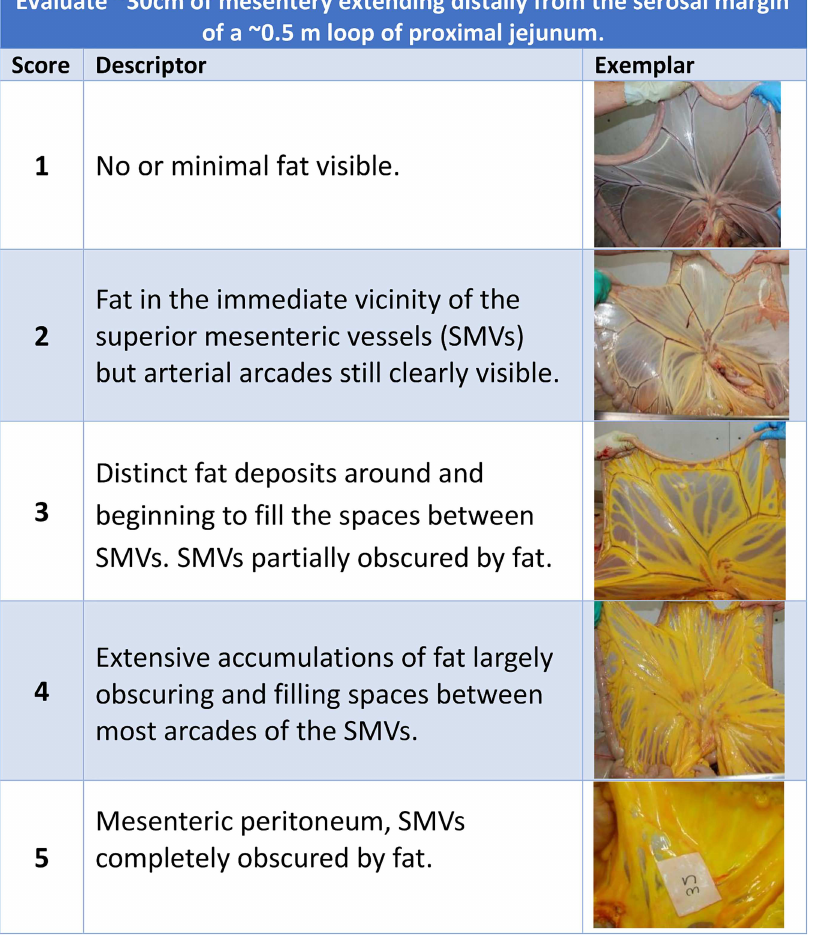
Fig 1. Example EQUIFAT scoring systemfor mesenteric adipose depot. The EQUIFAT scoringsystem was developed from the rankingof anatomically-defineddepot-specific photographic images in order of increasing visuallyapparentadiposity.Detaileddescriptorsfor each score (1–5) were generatedand representative images are providedto aid in the use of the